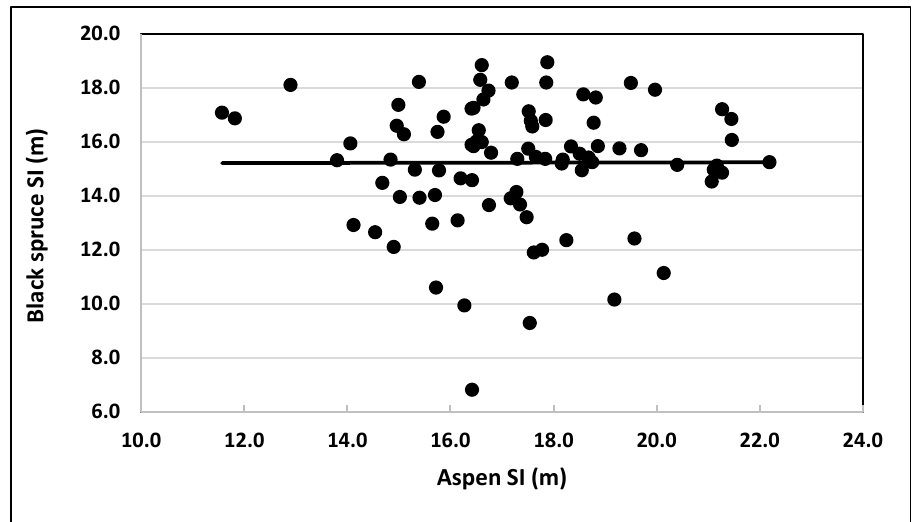
Figure 7. Observed values of site indices (base age 50 BHA) of black spruce plotted against their counterparts for trembling aspen grown in natural mixed stands.